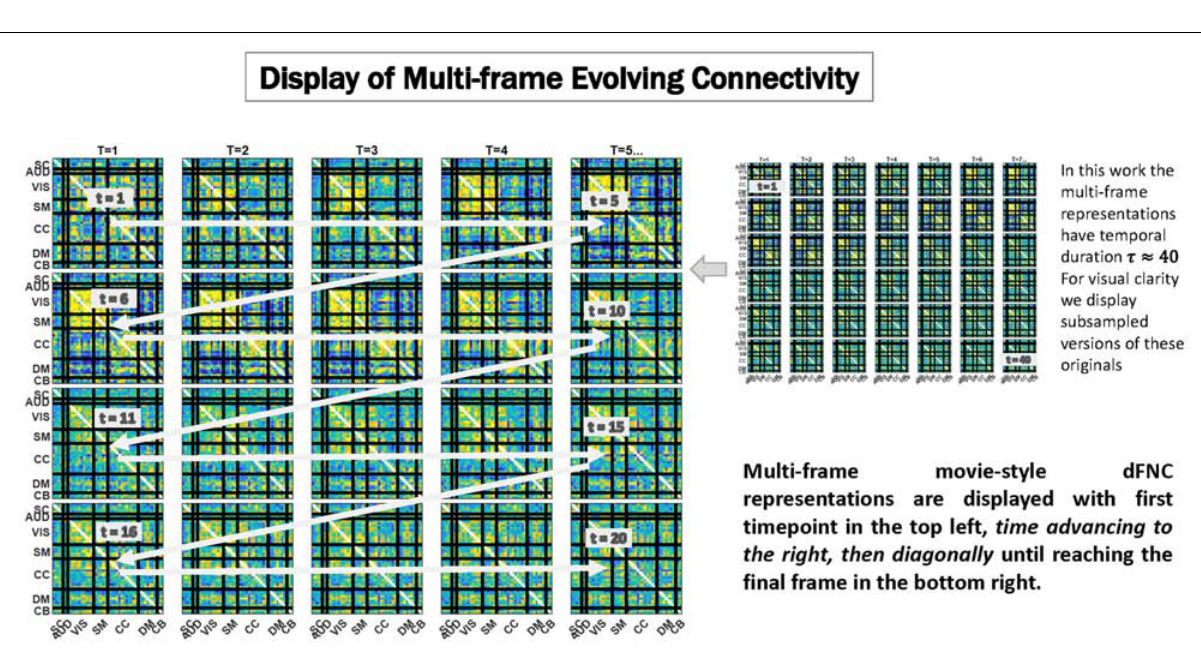
FIGURE 6 | We display temporally evolving dFNCs as a sequence of frames in which the first time point is always the top leftmost subplot, and with time advancing from left to right, then clockwise diagonally back to the first subplot in the subsequent row, until reaching the final frame of the sequence shown in the bottom rightmost subplot. Because these are very dense displays, the EVOdFNCs in this work, which have duration 44 time points are subsampled to show only every other frame in figures below. To avoid more crowding, colorbars are not displayed, but the range is fixed across EVOdFNCs, centered at 0 and bounded in [− q , q ] where q denotes the 95 th percentile of all magnitudes in the collection of